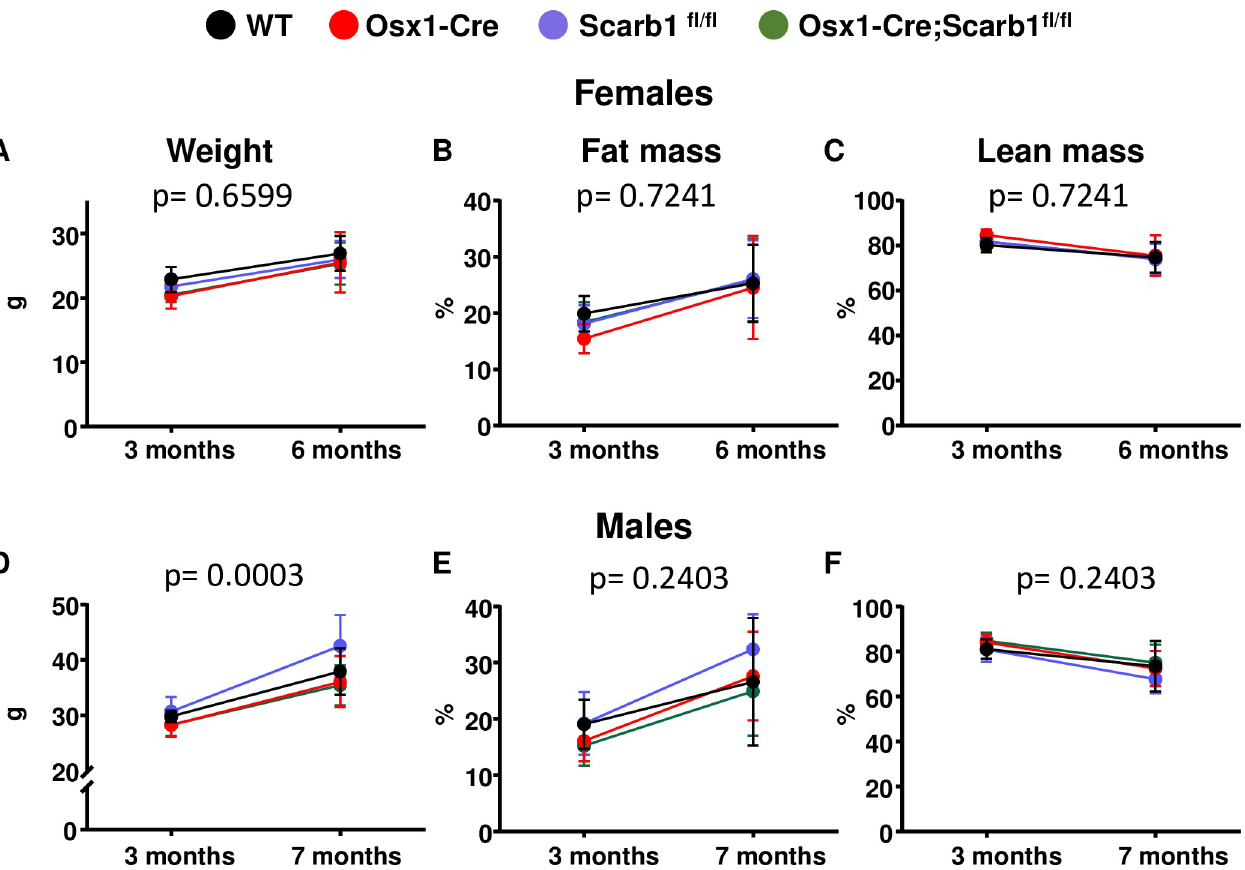
Fig 3. Deletion of Scarb1 in Osx1-Cre expressing cells does not affect weight, fat or lean mass in both sexes. (A) Weight measurements, (B) fat mass and (C) lean mass at 3 and 6 months of age in female mice [WT n = 9; Osx1-Cre n = 10; Scarb1 fl/fl n = 13; Osx1-Cre;Scarb1fl/fl n = 12]. Adjusted p-values, calculated by repeated measures using two-way ANOVA are shown. (D) Weight measurements at 3 and 7 months of age in male mice [WT n = 6; Osx1-Cre n = 15; Scarb1 fl/fl n = 15; Osx1-Cre;Scarb1 fl/fl n = 8]. The measurements of total weight, by ANOVA repeated measures, indicated differences in the rate of weight gain between the genotypes. Further analysis, showed Scarb1 fl/fl mice gained the most weight (average 11.82 ± 3.23 g) between the two time points, while WT, Osx1-Cre and Osx1-Cre; Scarb1 fl/fl gained 8.08 ± 3.46 g, 7.76 ± 3.23 g and 9.09 ± 2.22 g respectively. (E) Fat mass and (F) lean mass of the same mice as in (D) [WT n = 5–6; Osx1-Cre n = 14–15; Scarb1 fl/fl n = 15; Osx1-Cre;Scarb1 fl/fl n = 8]. Data are shown as mean and standard